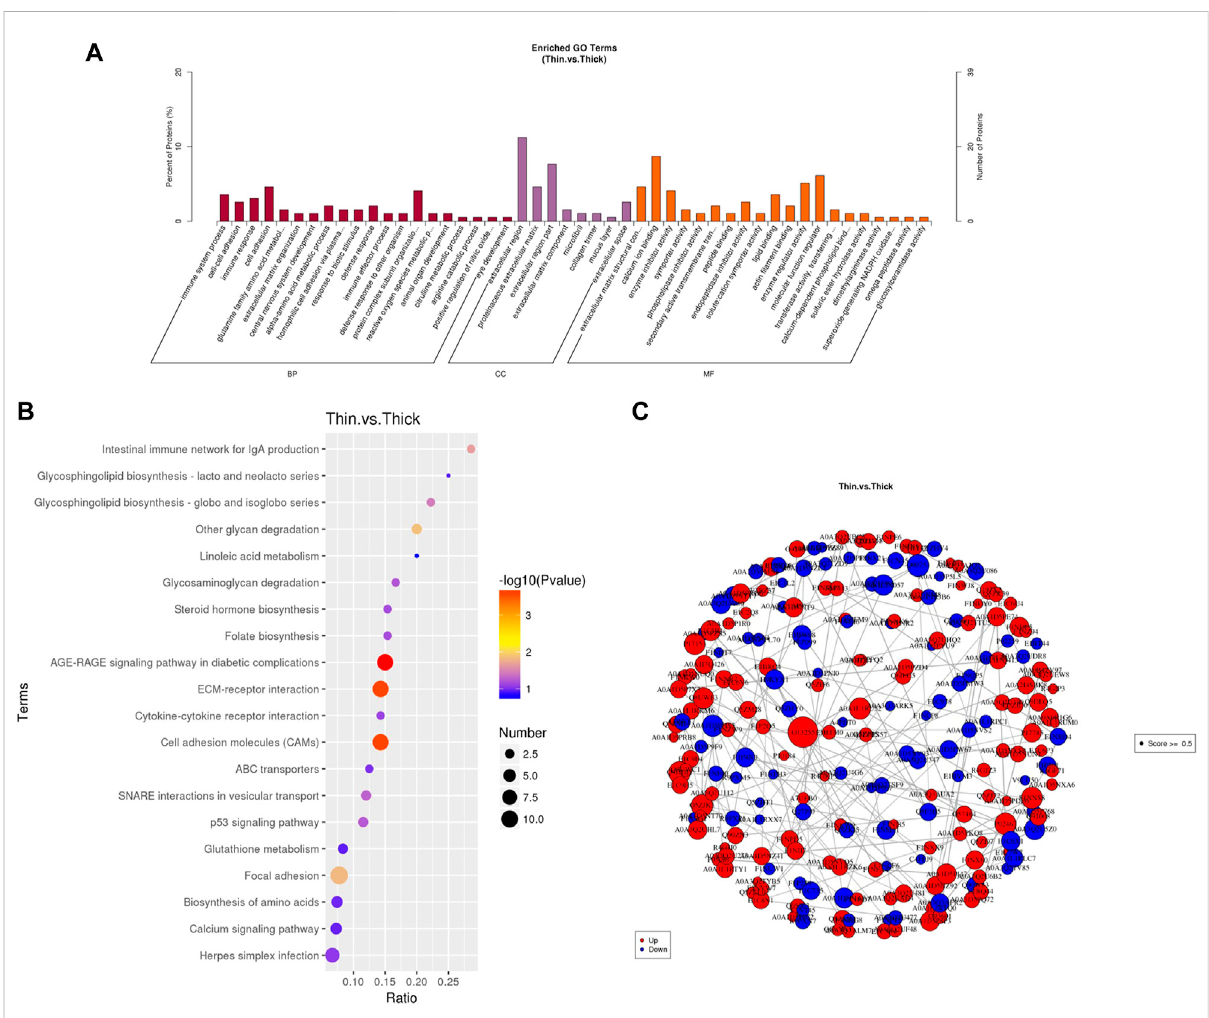
FIGURE 2 Differentially expressed proteins (DEGs) identi fi ed for the uterus between HE and LE hens. (A) GO analysis result of DEPs between HE and LE hens; (B) top 20 results of KEGG analysis of DEPs between HE and LE hens; (C) protein – protein interaction network of the DEPs.